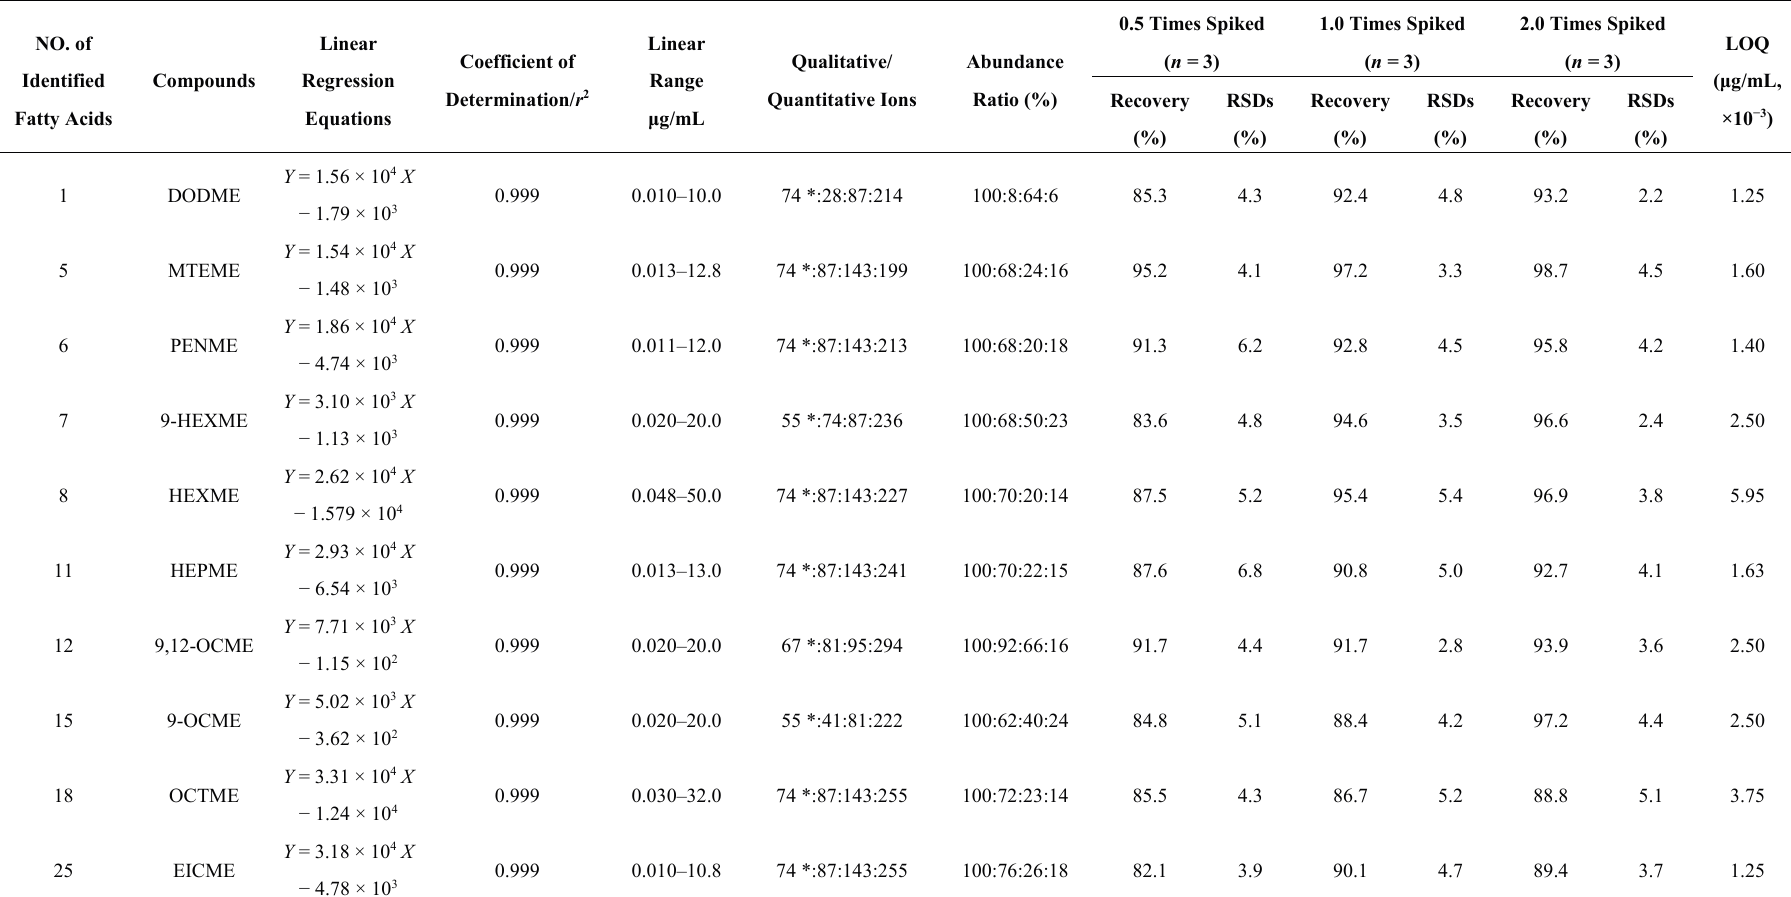
Table 2. The linear regression equations, the correlation coefficient ( r ), limit of quantification (LOQ), recoveries of 10 fatty acids under GC–EI-qMS selective ion monitoring (SIM)